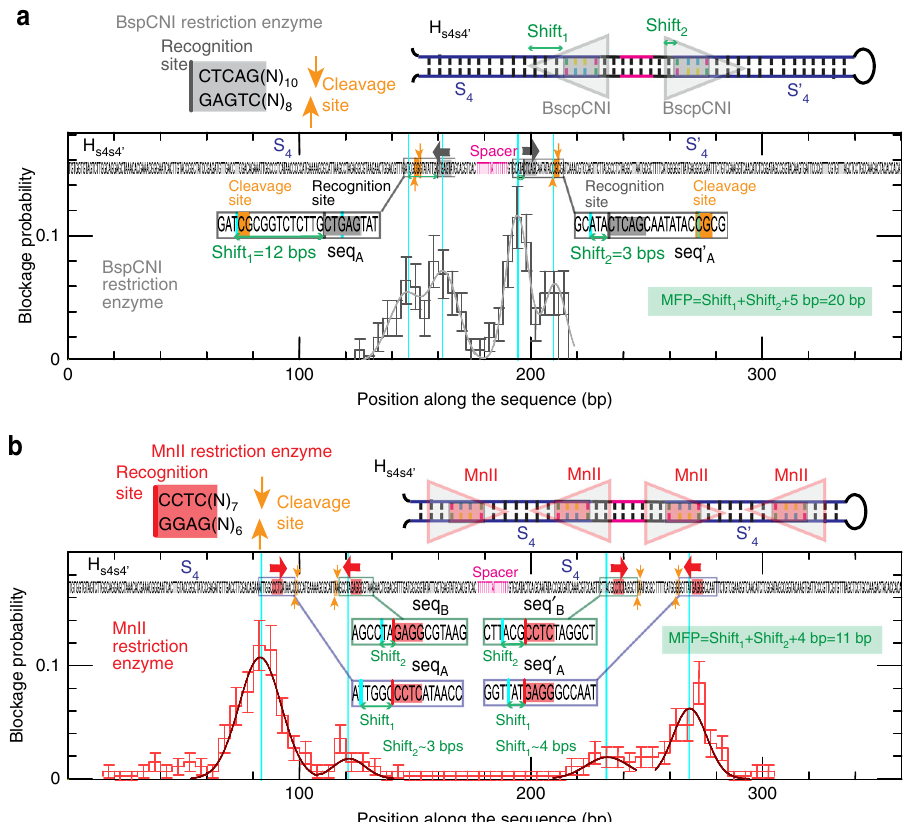
Fig. 6 Multiple binding sites and fl anking sequences in non-palindromic restriction enzyme binding. a Distribution of blockage positions obtained applying the FC protocol with the H s 4 s 4 ′ hairpin in presence of the BspCNI restriction enzyme (number of beads = 155). Error bars are inversely proportional to the square root of the number of points for each bin. The results show four peaks that can be related to both recognition and cleavage sites. Schematics of recognition and cleavage of the BspCNI enzyme, as well as its binding to the H s 4 s 4 ′ hairpin is shown in the upper part of the panel. The MFP is extracted from the shifts measured in the forward and reverse sequences. b Distribution of blockage positions obtained by applying the FC protocol to the H s 4 s 4 ′ hairpin in presence of the MnII restriction enzyme (number of beads = 139). Error bars are inversely proportional to the square root of the number of points for each bin. The results show four peaks that can be related to the four repeats of the recognition site present along the sequence. The shifts associated to the enzyme head and back, shift 1 and shift 2 , can be measured in both S 4 and S ′ regions and so the MFP. The recognition site can be also determined from 4 the correlation analysis shown in Supplementary Fig. 10. The different weights of the fi tted Gaussian functions are attributed to the different binding stabilities induced by the DNA fl anking sequences. Schematics of the recognition and cleavage of the MnII enzyme as well as its binding to the H s 4 s 4 ′ hairpin is shown in the upper part of the